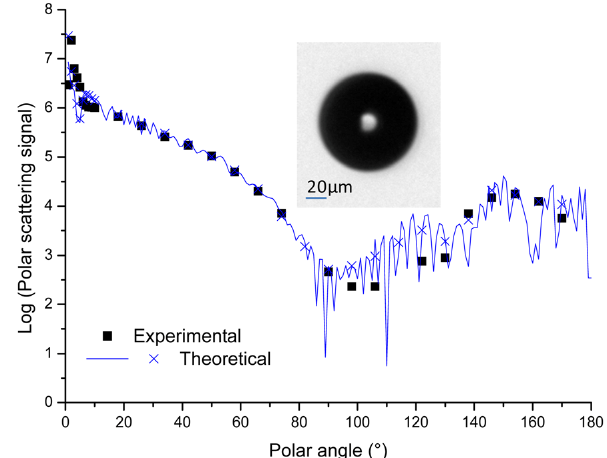
Fig. 3. Comparison between the experimentally obtained scatter- ing intensity of light versus polar angle and the theoretical curve for a water droplet of 94µm diameter. Crosses are the averages of Figure 3. Comparison between the experimentally obtained scattering intensity of light versus 3 theoretical values over the solid angle covered by the correspond- polar angle and the theoretical curve for a water droplet of 94 µm diameter. Crosses are the 4 ing detector.Also keep in mind that the log scale emphasizes low averages of theoretical values over the solid angle covered by the corresponding detector.Also 5 intensity values and, hence, the difference between experiment and keep in mind that the log scale emphasizes low intensity values and, hence, the difference 6 theory in our between experiment and theory in our case. 7